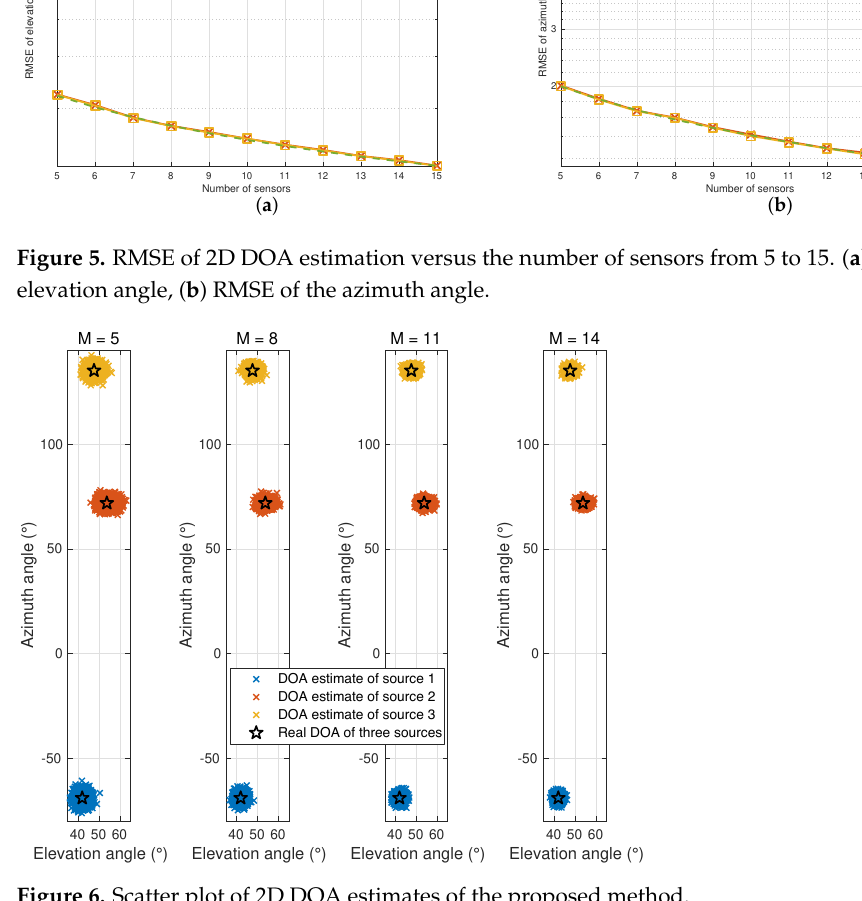
Figure 6. Scatter plot of 2D DOA estimates of the proposed